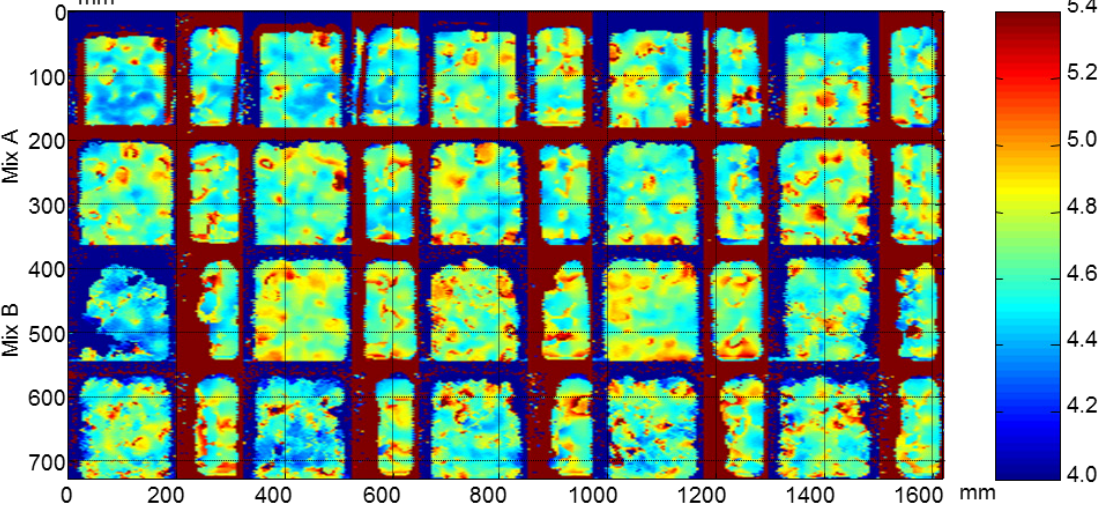
Figure 25. Velocity maps of concrete specimens after the